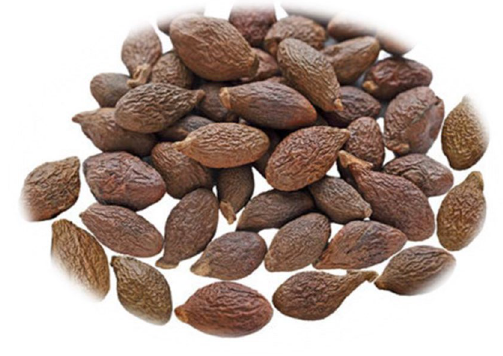
Fig. 21 Gums of Malva nuts as a coagulant